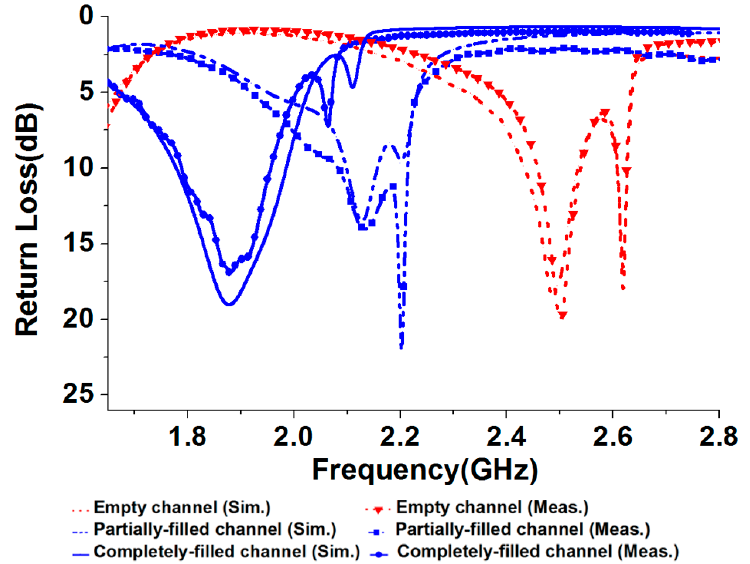
Figure 6. Simulated and measured return losses of the presented quasi-Yagi antenna.